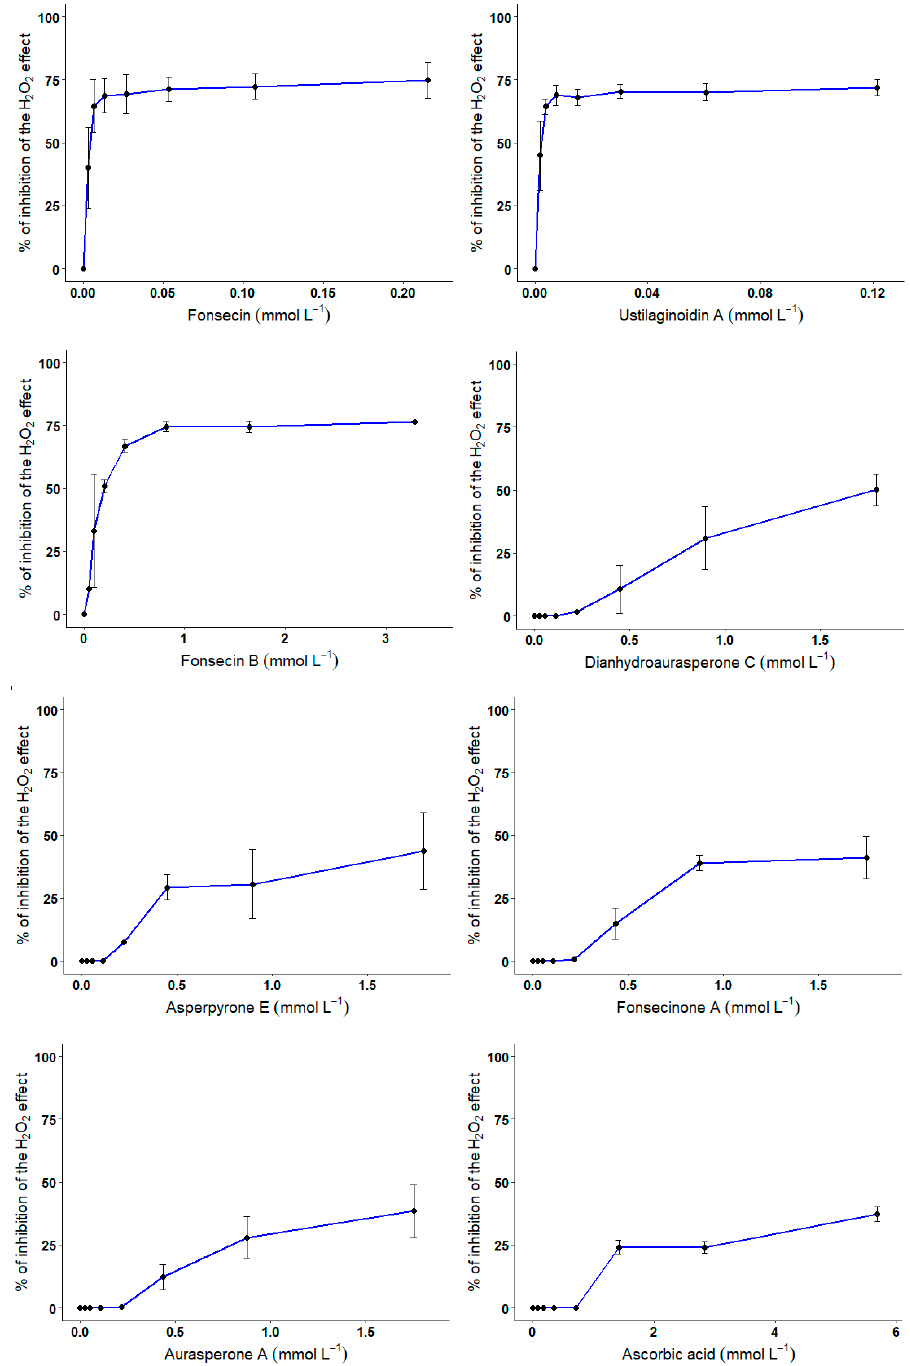
Figure 6. Protective effect of compounds 1 – 7 on H 2 O 2 -mediated cell death in CHO cells. CHO cells were exposed for 30 min to increasing concentrations of compounds 1 – 7 or ascorbic acid in the presence of 300 μ mol L − 1 of H 2 O 2 . At the end of the incubation period, cell viability was